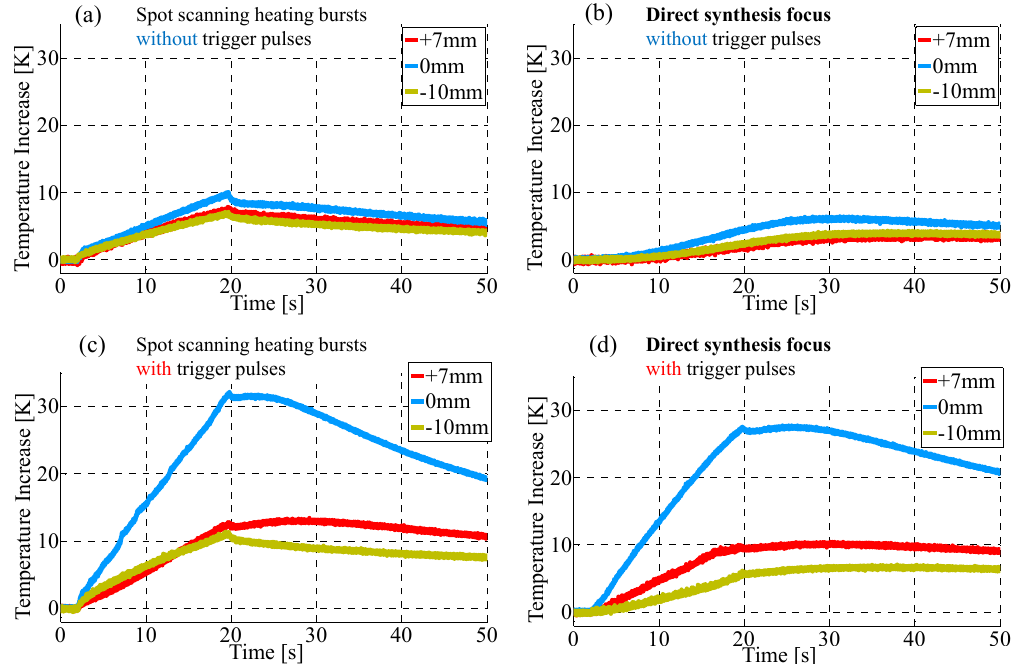
Figure 9. Temperature increases averaged over two measurements at the geometric focus, and 10 mm backward and 7 mm forward from it [35]. ( a , c ) heating bursts alone without trigger pulses and trigger HIFU sequence with spot scanning focus shown in Figure 1b, respectively; ( b , d ) those with a directly synthesized focus shown in Figure 1c. The total duration time of HIFU exposure was approximately 17.7 s.